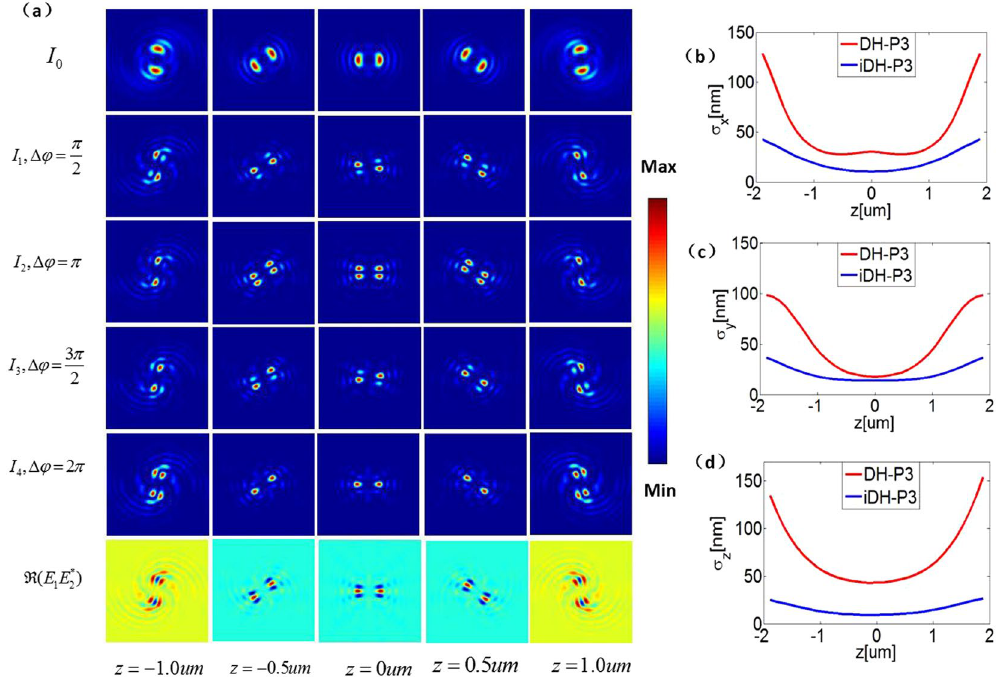
Figure 2. ( a ) Top row: the DH PSF using the non-interferometric detection scheme; Middle four rows: Four phase-shifted intensity images I 1 , I 2 , I 3 , I 4 recorded by the four cameras using the interferometric detection scheme, which clearly exhibit the rotation of the pattern as the defocus changes. Bottom row: iDH PSF: iDH-P3 ( ⁎ R E E ( ) ). In comparison with the DH PSF, the size of the main lobe in the iDH PSF is significantly decreased 1 2 because the interference effect occurs in the azimuthal direction. In addition, the iDH-PSF rotates across the same angle as the DH PSF at the same defocus. ( b – d ) Theoretical localization precision σ x , σ y , σ z using the DH PSF and the iDH PSF,